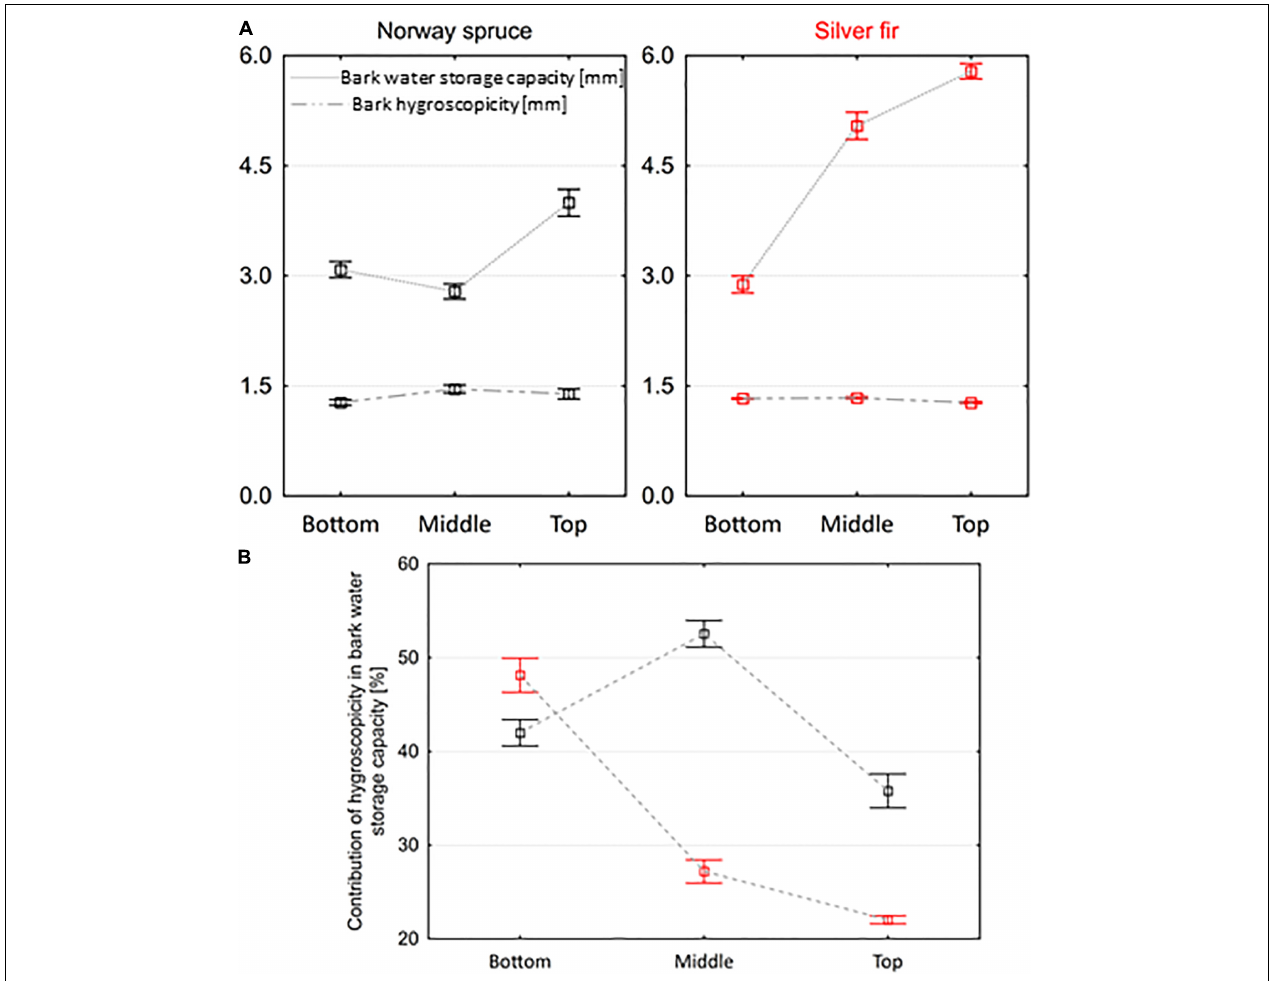
FIGURE 4 | Variation in (A) bark water storage capacity and hygroscopicity and (B) the proportion of bark water storage capacity occupied by bark hygroscopicity along stems of Norway spruce and silver fir trees (mean ±